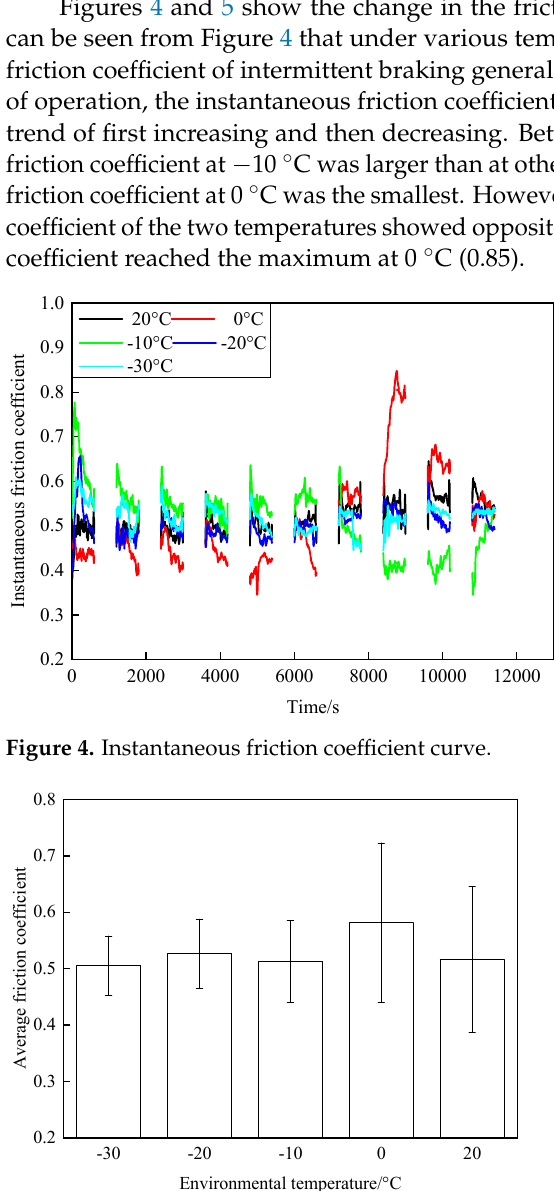
are 0.516, 0.513, 0.527, and 0.506, respectively, which are 11.8%, 12.3%, 9.9%, and 13.5% lower than the average friction coefficients at 0 ◦